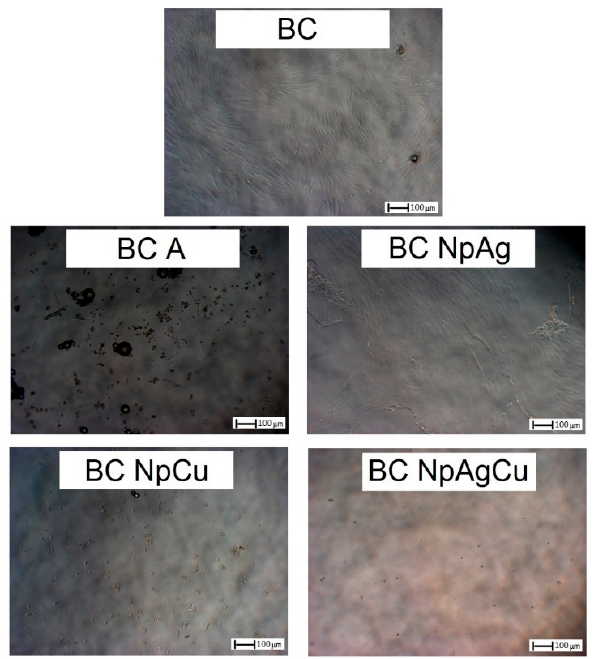
Figure 6. Evaluation of morphology of cells grown in close proximity to the materials: Modified bone cements with 3% w / w of modifiers (the presented pictures are representative for 3